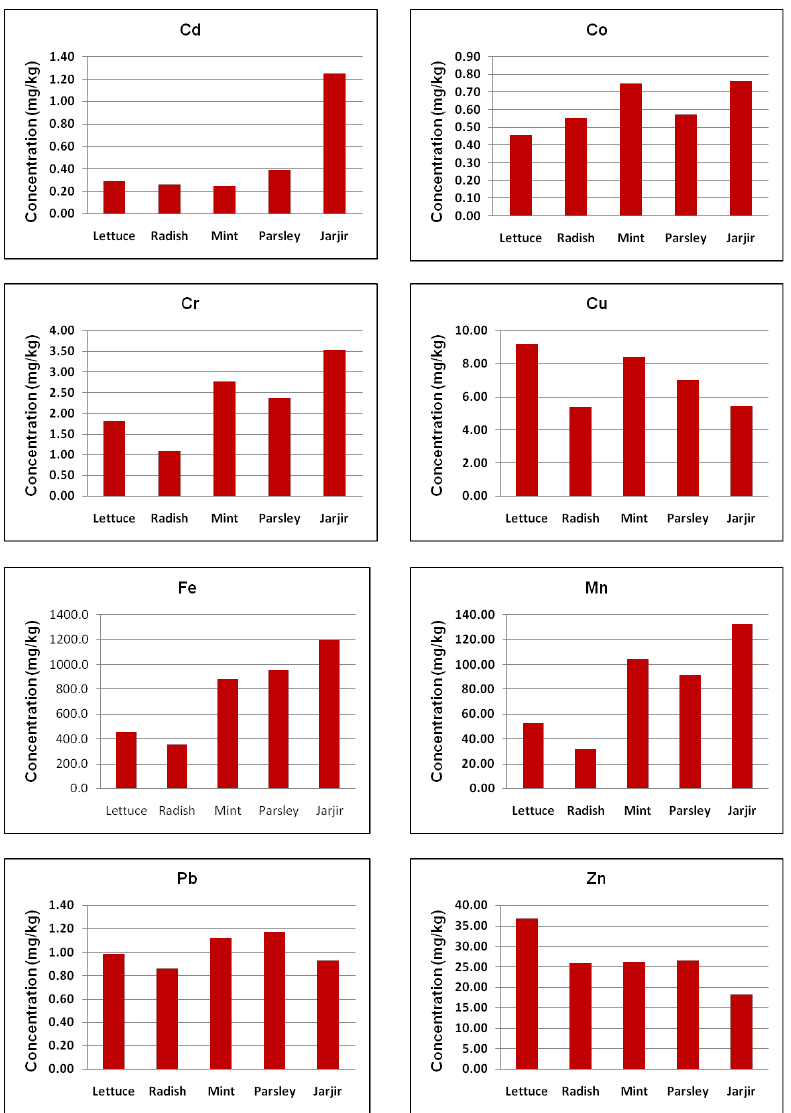
Figure 2. Graph representing the heavy metal distribution in leafy vegetables; the mean concentra- tions (on dry weight basis) include all the tested sites.